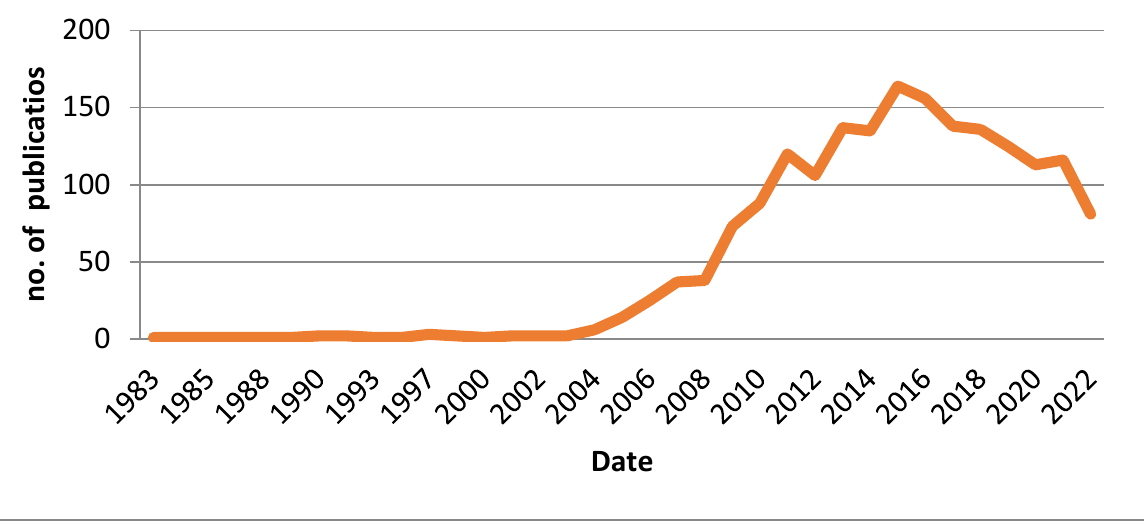
Figure 2. Number of relevant publications per year, about feature detectors and descriptors (statistics from November 2022).